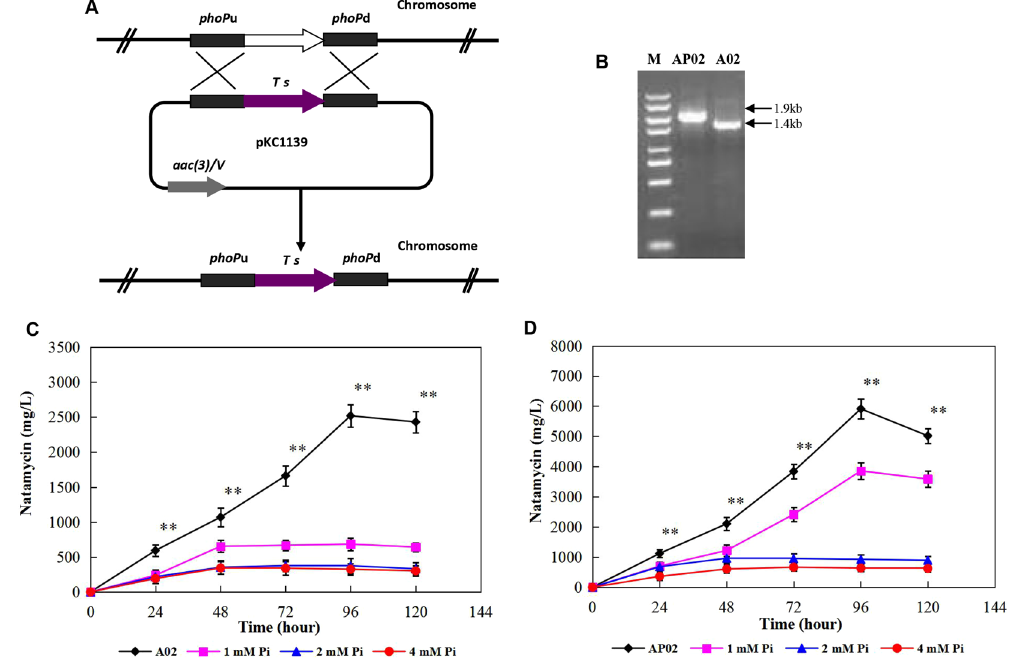
Figure 4. Construction of the phoP mutant and the effect of phosphate concentration on natamycin production in A02. ( A ) Schematic showing the deletion of phoP in A02. ( B ) PCR verification of phoP mutant. Lane M, DNA Marker. ( C ) Effect of increasing phosphate concentrations on natamycin production in A02. ( D ) Effect of increasing phosphate concentrations on natamycin production in AP02. The experiments were repeated three times, and the data shown are the mean ± SE; * P < 0.05, ** P <